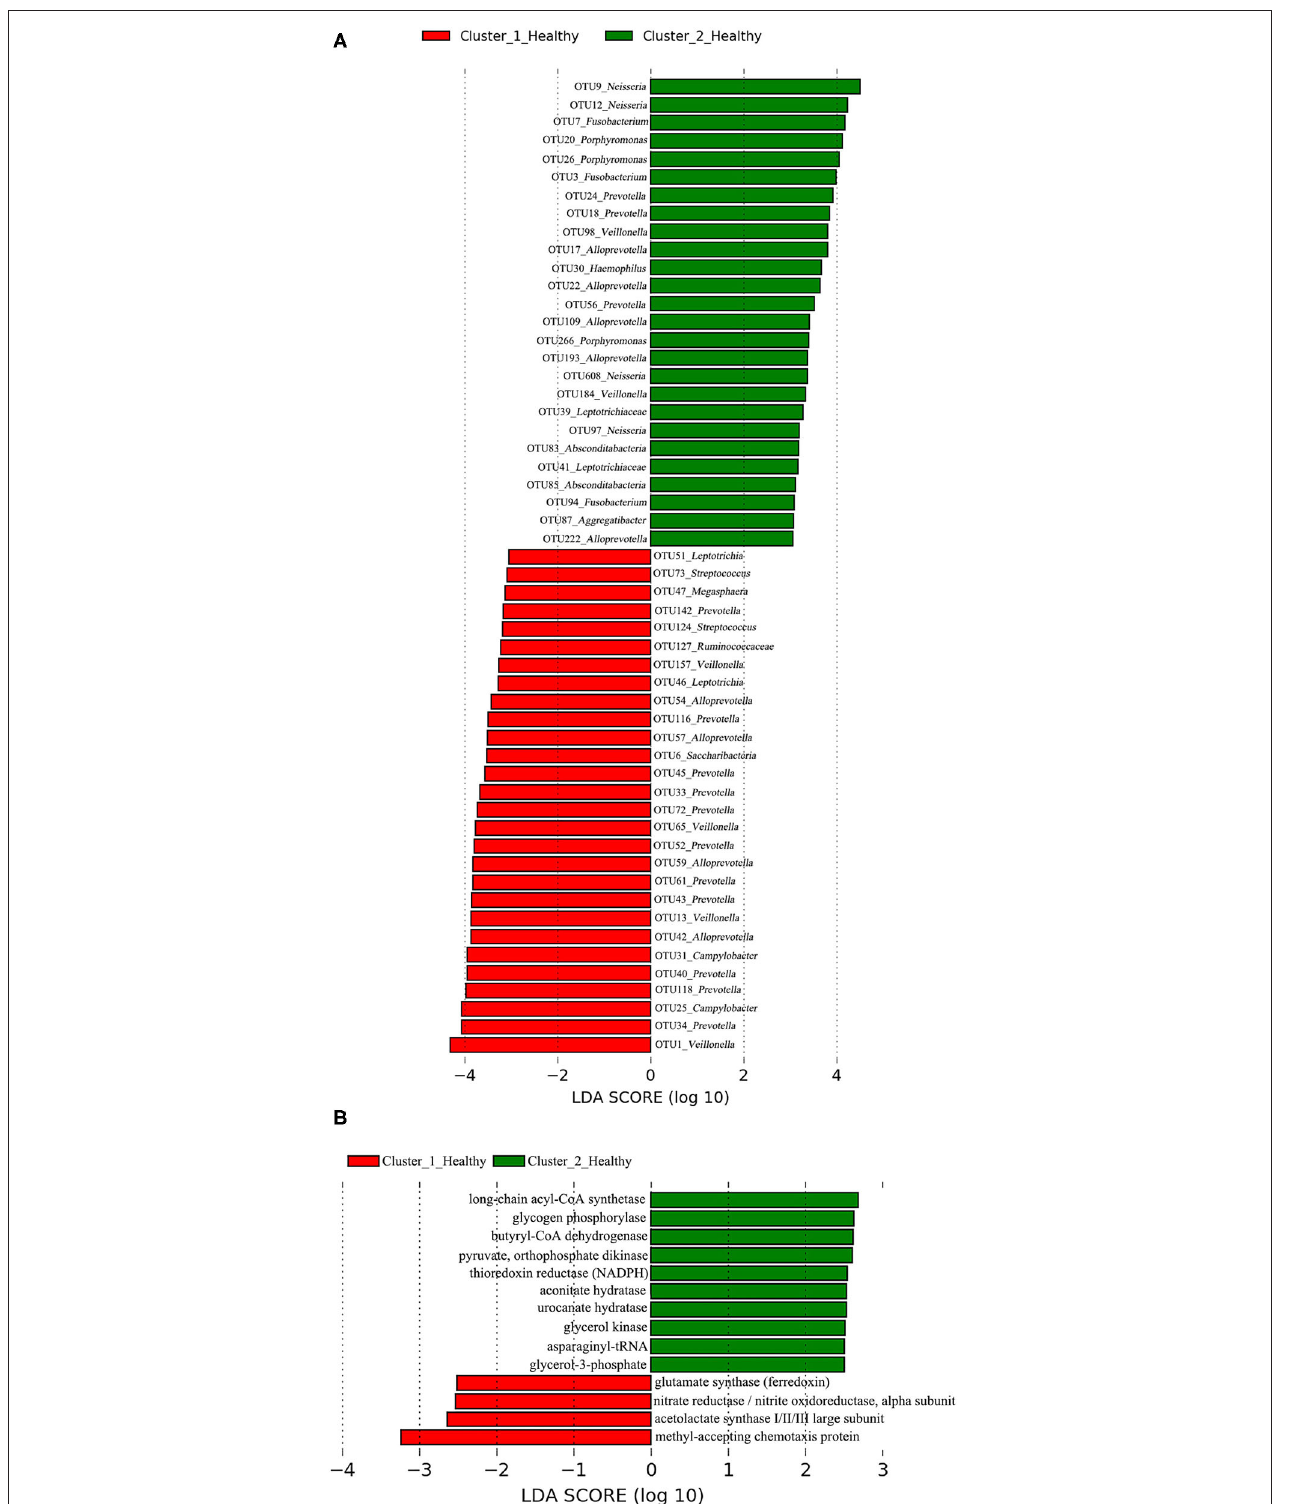
FIGURE 8 | LEfSe analyses determined the (A) OTUs and (B) functional metabolites associated with each of the two clustered OP microbiotas of healthy subjects.